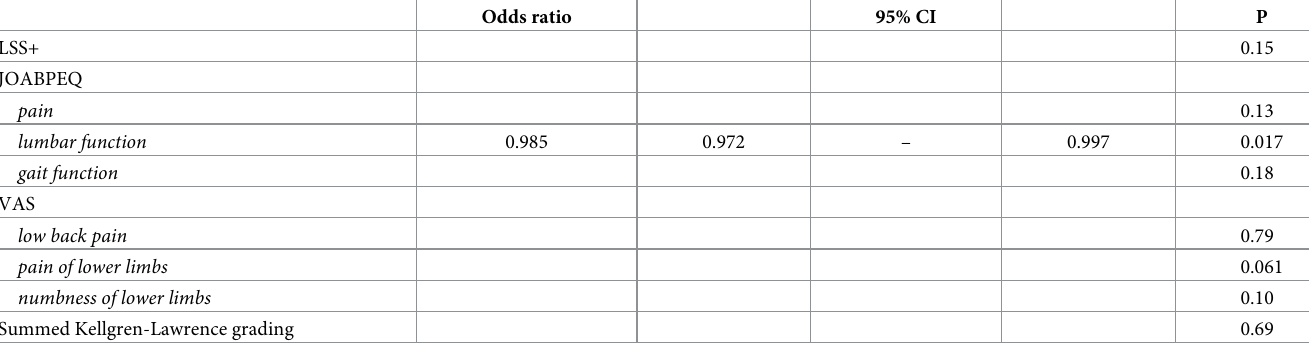
Table 3. The impact of parameters related to lumbar degenerative disease on MCI.